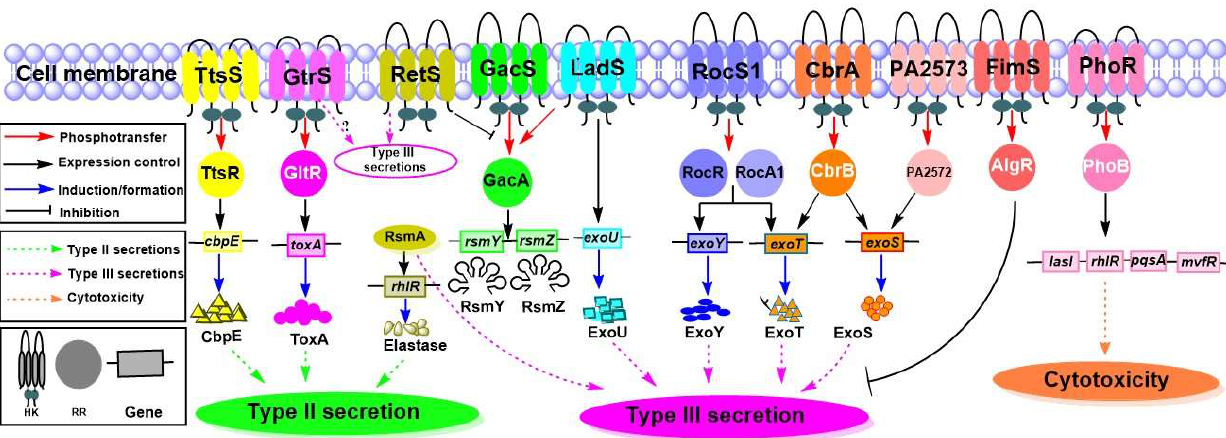
Figure 6. TCS-dependent regulation of secreted proteins. This figure summarizes important sensor HKs and their cognate RRs that are responsible for proteins secreted by type II, type III, and Txc secretion systems. The TtsSR is responsible for the Txc secretion and is involved in the production of CbpE. GtrS-GltR is responsible for the production of ToxA, which is an important toxin secreted by the type II secretion system. GacSA interacts with LadS and RetS in agonistic and antagonistic manners, respectively. GacSA controls both elastase and type III secretion systems by producing RsmY and RsmZ, which prevent the activities of RsmA by forming a RsmA-RsmY-RsmZ complex. LadS, specifically, is involved in regulation of ExoU. The RocS1-RocR-RocA1 is involved in the production of ExoY and ExoT toxins secreted by the type III secretion system. CbrAB has a role in the synthesis of ExoS and ExoT toxins. The PA2573-PA2572 is involved in the syn- thesis of the ExoS toxin, and the FimS-AlgR is responsible for suppressing type III secretion. The PhoRB is required for cytotoxicity under a phosphate-limited condition.